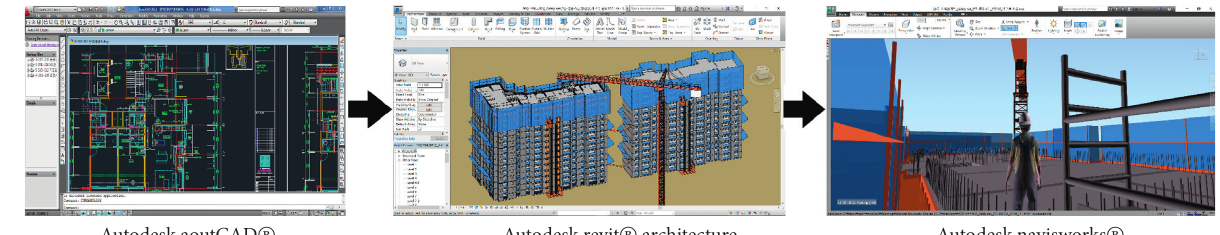
Figure 2: Different steps in creating animated BIM safety